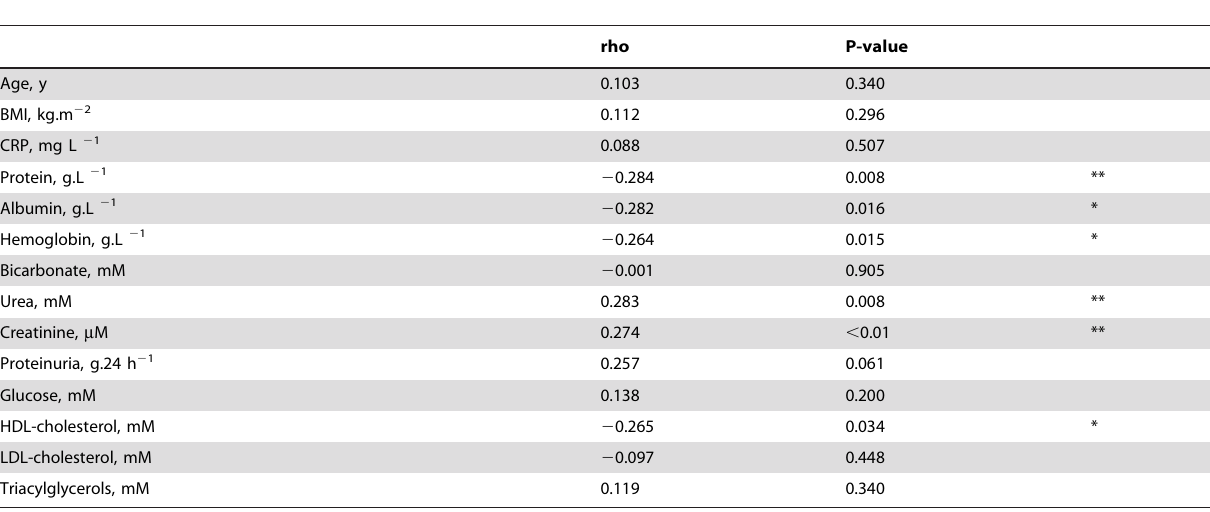
Table 3. Univariate correlations with ZAG concentrations.